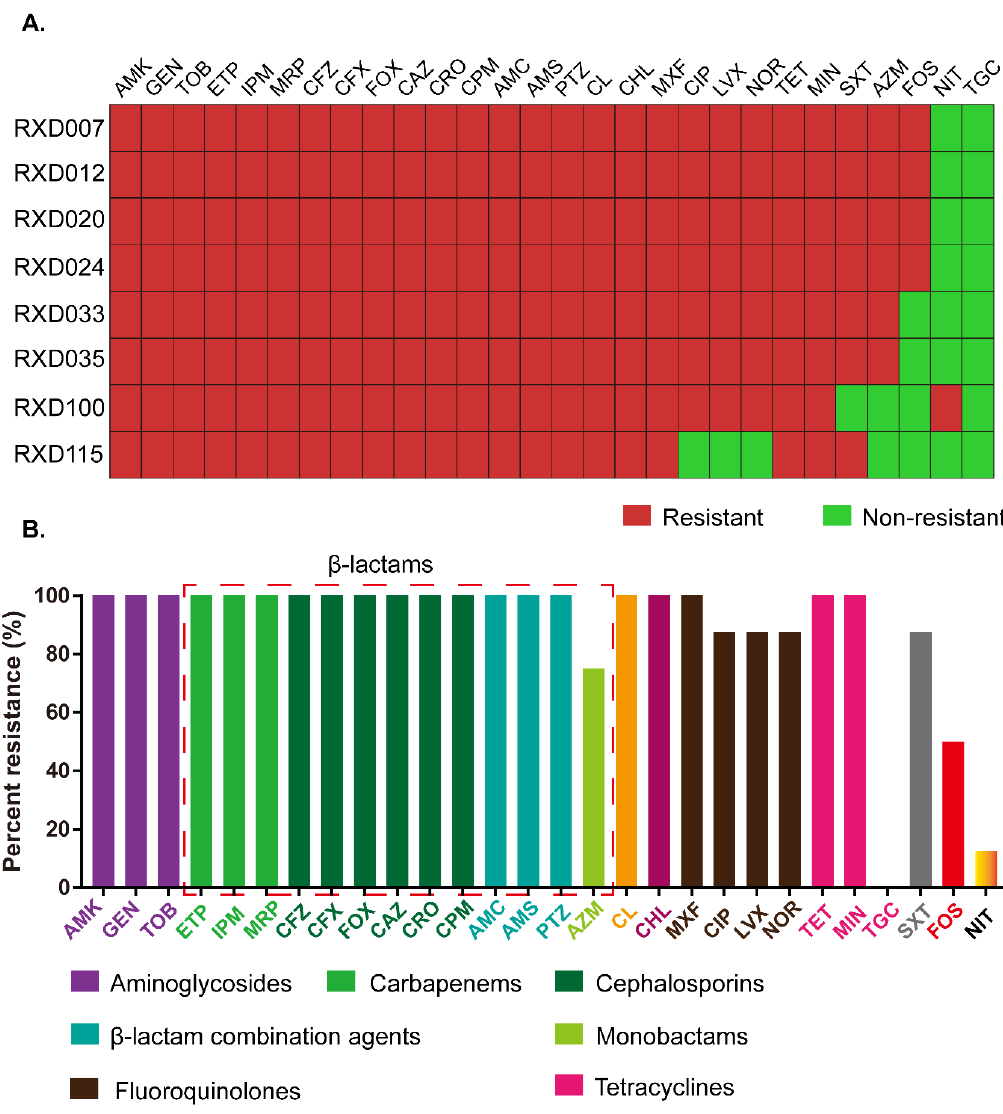
Figure 1. Antimicrobial susceptibility profile of the eight carbapenem-resistant and colistin-resistant Escherichia coli isolates. ( A ) Heatmap showing resistance and multidrug resistance phenotypes of each of the E. coli isolates; ( B ) Percent strains resistant to the tested antibiotics. AMK: amikacin; GEN: